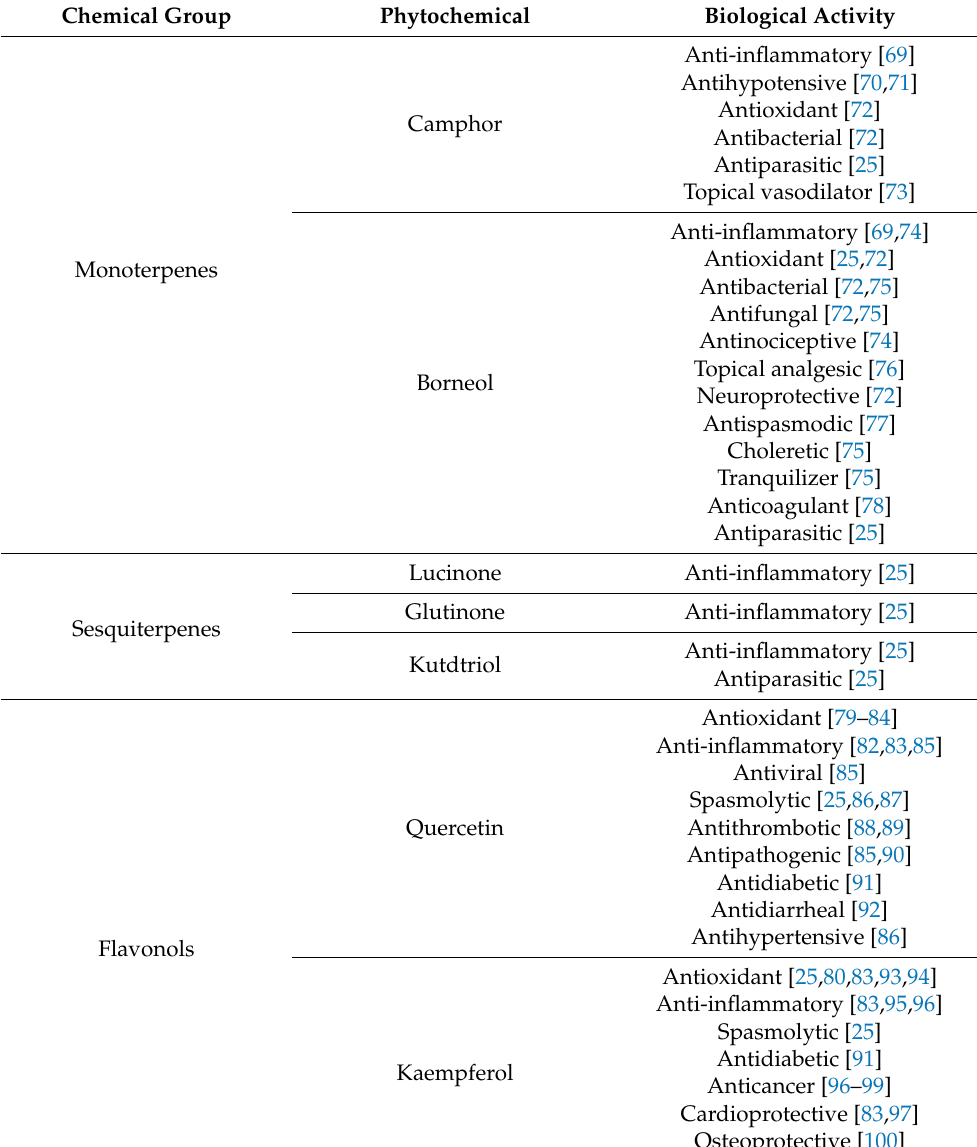
Table 8. Biological activity of the compounds in higher proportions present in the essential oil of Chiliadenus glutinosus